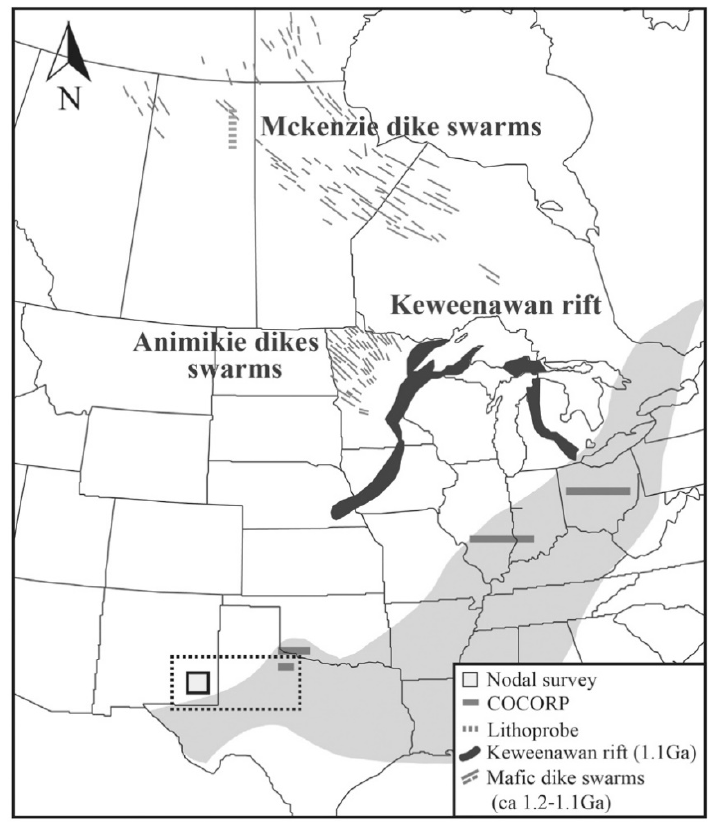
Figure 11. Comparison of the extent of sills, represented by LITHOPROBE seismic lines, and exposed dikes in northwest Canada associated with the Proterozoic McKenzie event with the extent of layered reflectors that appear to be correlative beneath much of the US midcontinent sedimentary rock cover, as represented by COCORP surveys. The lightly shaded area indicates the inferred extent of the Proterozoic Granite-Rhyolite provide [70]. After Kim and Brown [69].